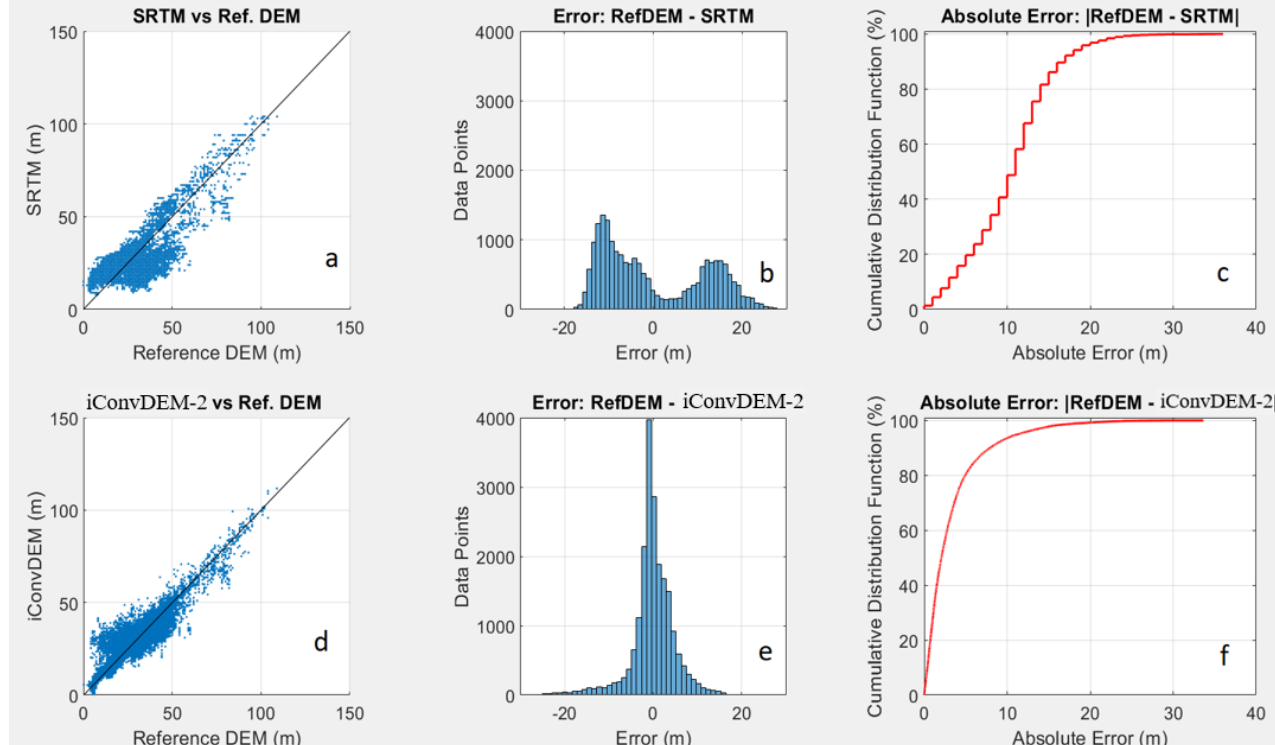
Figure 10. Statistical analysis for sub-area within validation site in Nice, versus reference DEM, of: ( a ) elevations of SRTM DEM, ( b ) errors of SRTM DEM, ( c ) absolute errors of SRTM DEM, ( d ) elevations of iConvDEM-2, ( e ) errors of iConvDEM-2 and ( f ) absolute errors of iConvDEM-2.